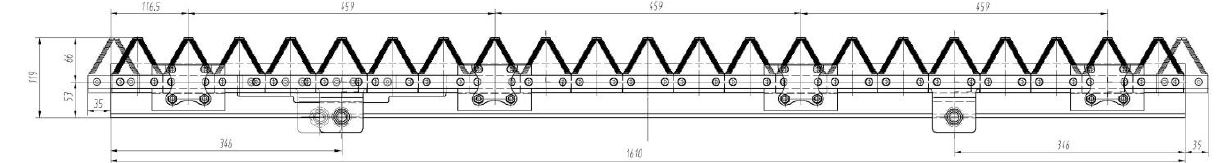
Figure A1. The mechanical diagram of cutting knife.